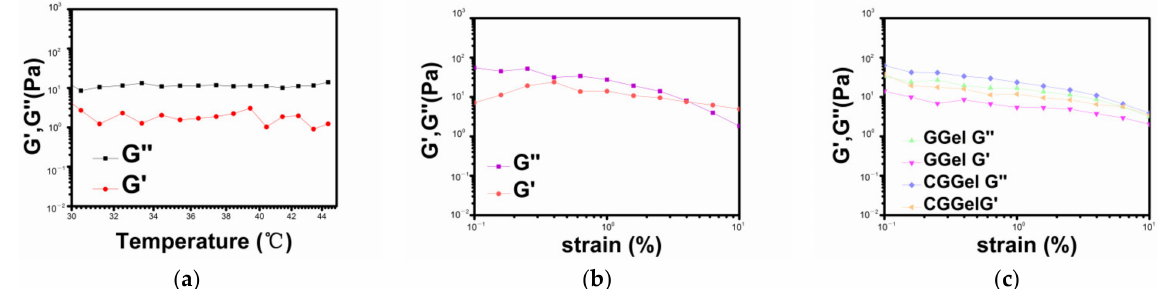
Figure 5. ( a ) The energy storage modulus G’) and loss modulus G”) of CGGel hydrogels at different temperatures. The energy storage modulus G’) and loss modulus G”) of Gel ( b ), GGel, and CGGel ( c ) hydrogels at different frequencies.